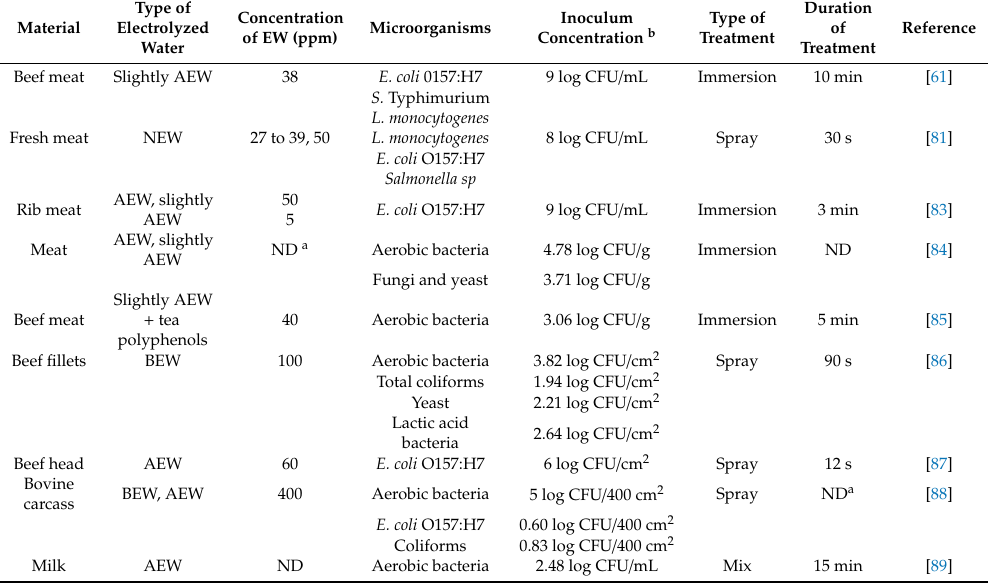
Table 5. Evaluations of electrolyzed water on cattle